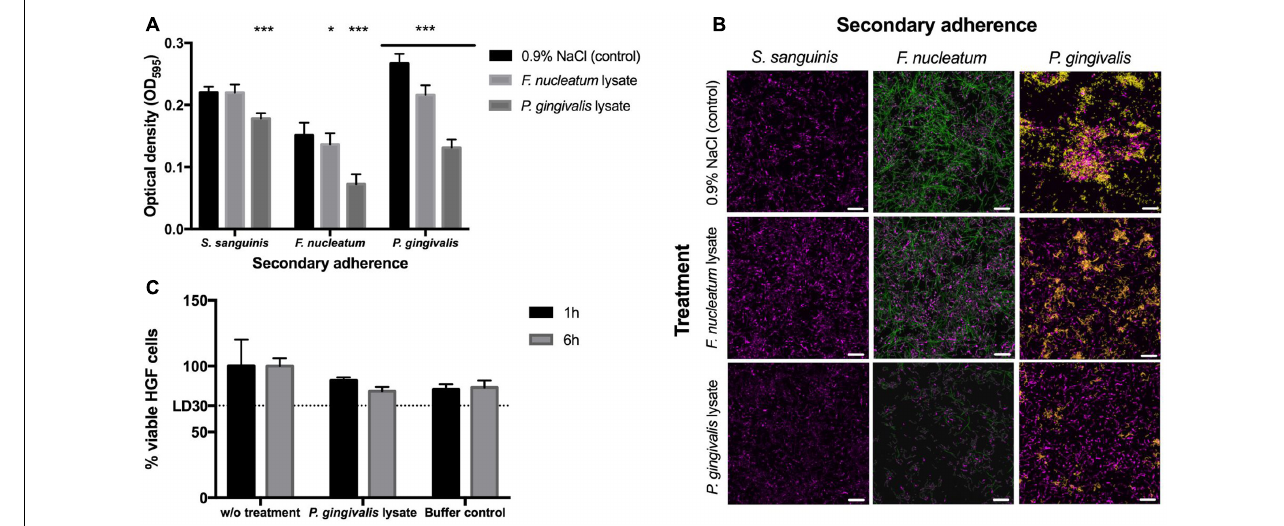
FIGURE 2 | Biofilm formation and cytotoxicity effects. (A) Crystal violet staining after 48 h. The 24-h-old S. sanguinis biofilms blocked with lysate or 0.9% NaCl before secondary adherence of S. sanguinis , F. nucleatum, or P. gingivalis for another 24 h ( N = 16). Asterisks denote statistical significance as follows: ∗ P < 0.05, ∗∗ P < 0.01, ∗∗∗ P < 0.001 ( N = 18). (B) FISH images to confirm the results obtained by crystal violet staining ( S. sanguinis depicted in magenta, F. nucleatum in green, and P. gingivalis in yellow; scale bar: 10 µ m) ( N = 3). (C) Cytotoxic effects of P. gingivalis lysate on human gingival cells (HGCs). The lethal dose (LD) as indication of lethality of 30% of the cells is indicated as LD30 ( N = 6). All data are presented as mean values ± standard